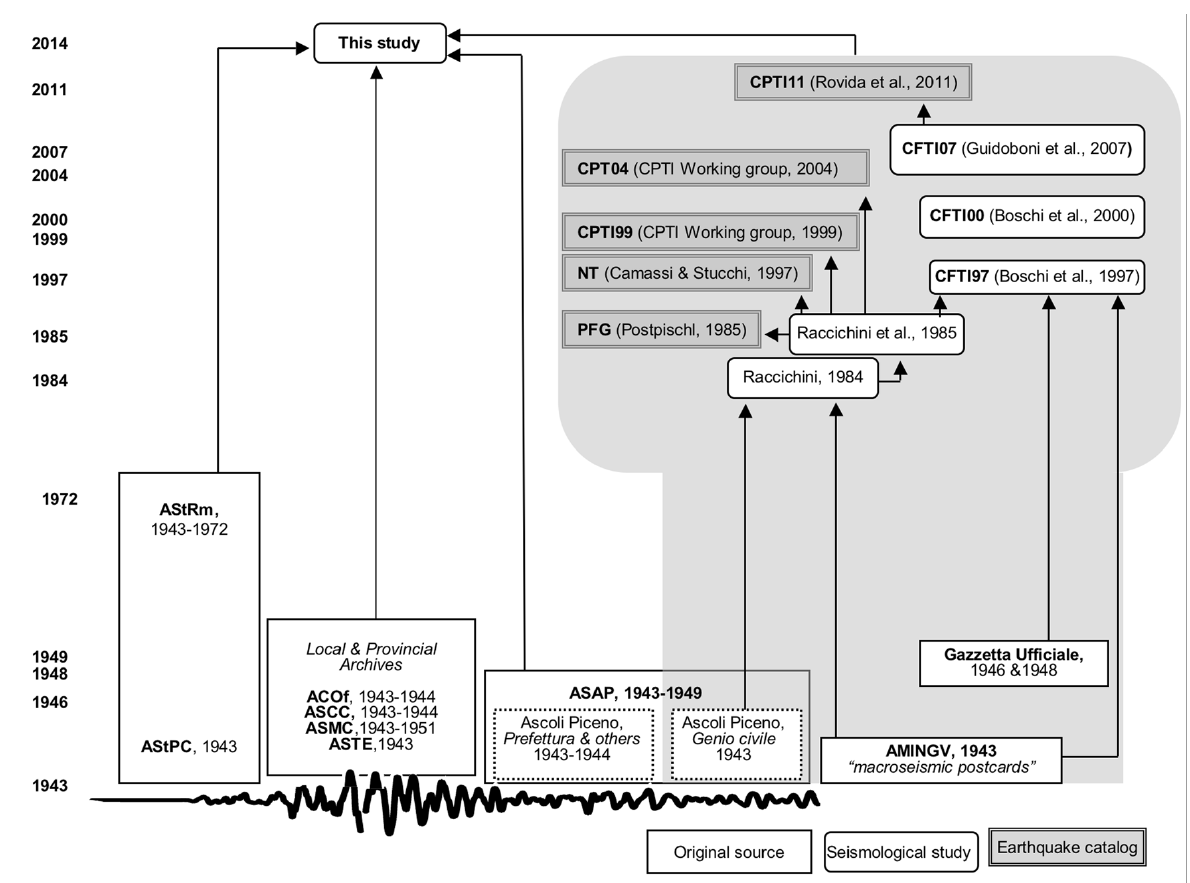
Figure 2. Sources used by earlier studies of the October 3, 1943 earthquake (shaded) and by this